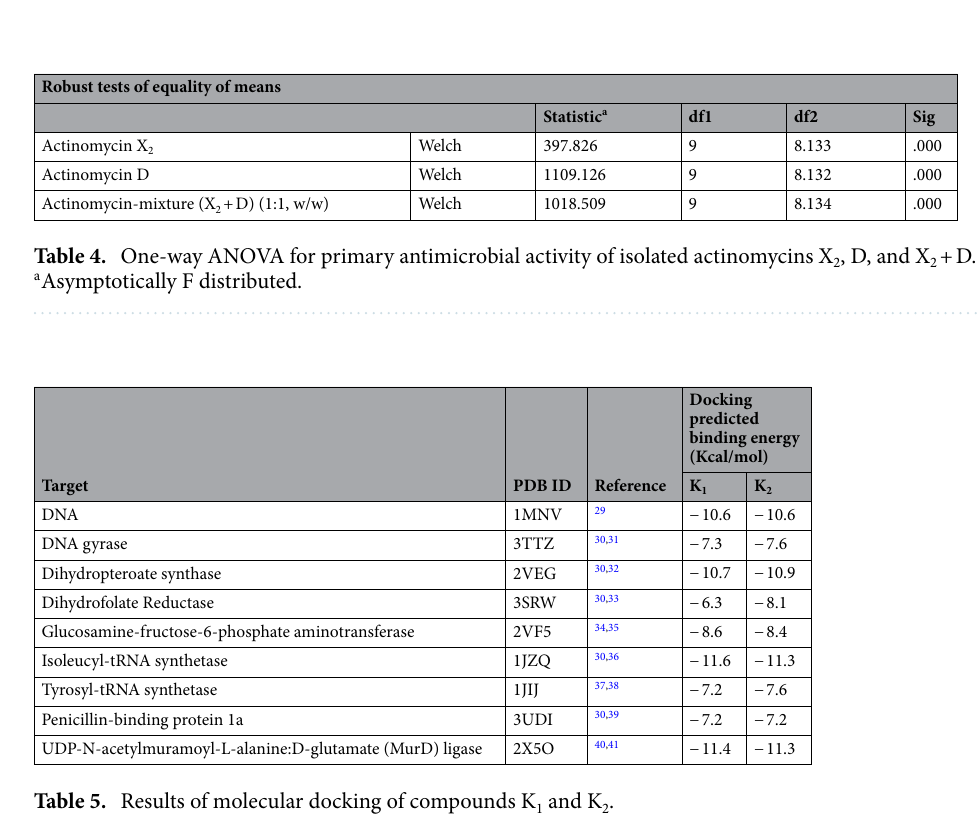
Table 5. Results of molecular docking of compounds K 1 and K 2 .